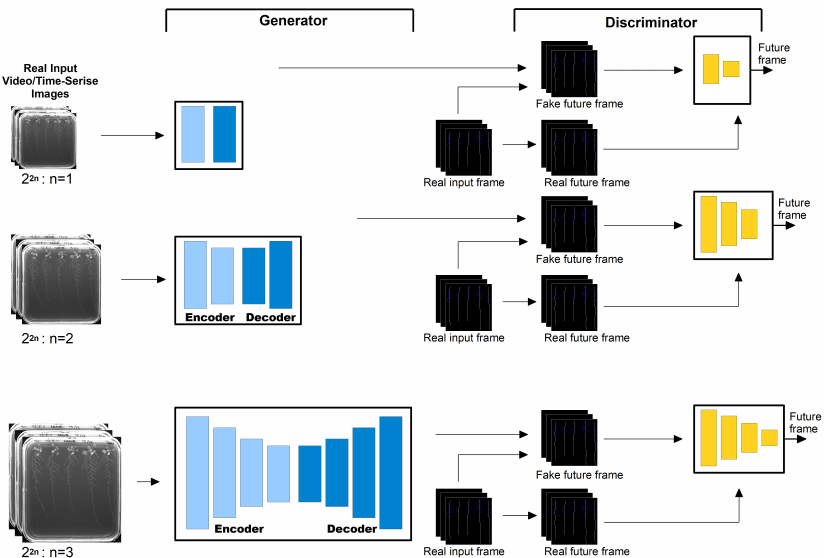
Figure 3. Proposed network architecture, based on FutureGAN